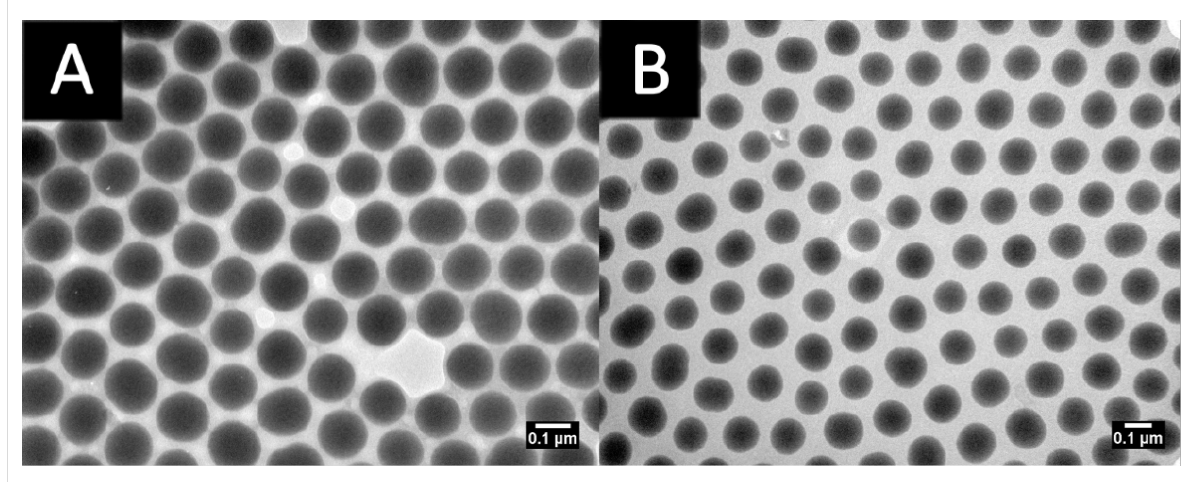
polymer chains slows down at higher conversions, the particles in solution continue to increase in size due to the solvent swelling the grafted polymer chains, thus increasing the apparent particle